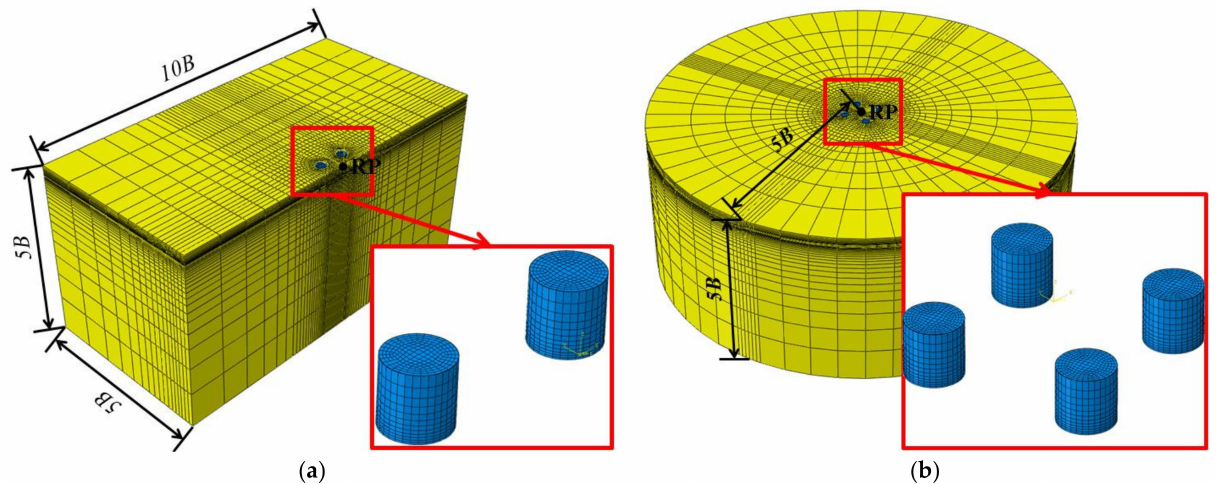
Figure 3. Example of 3D finite-element models for tetrapod bucket foundations when ( a ) ϕ = 0 ◦ ( b ) ϕ (cid:54) = 0 ◦ .